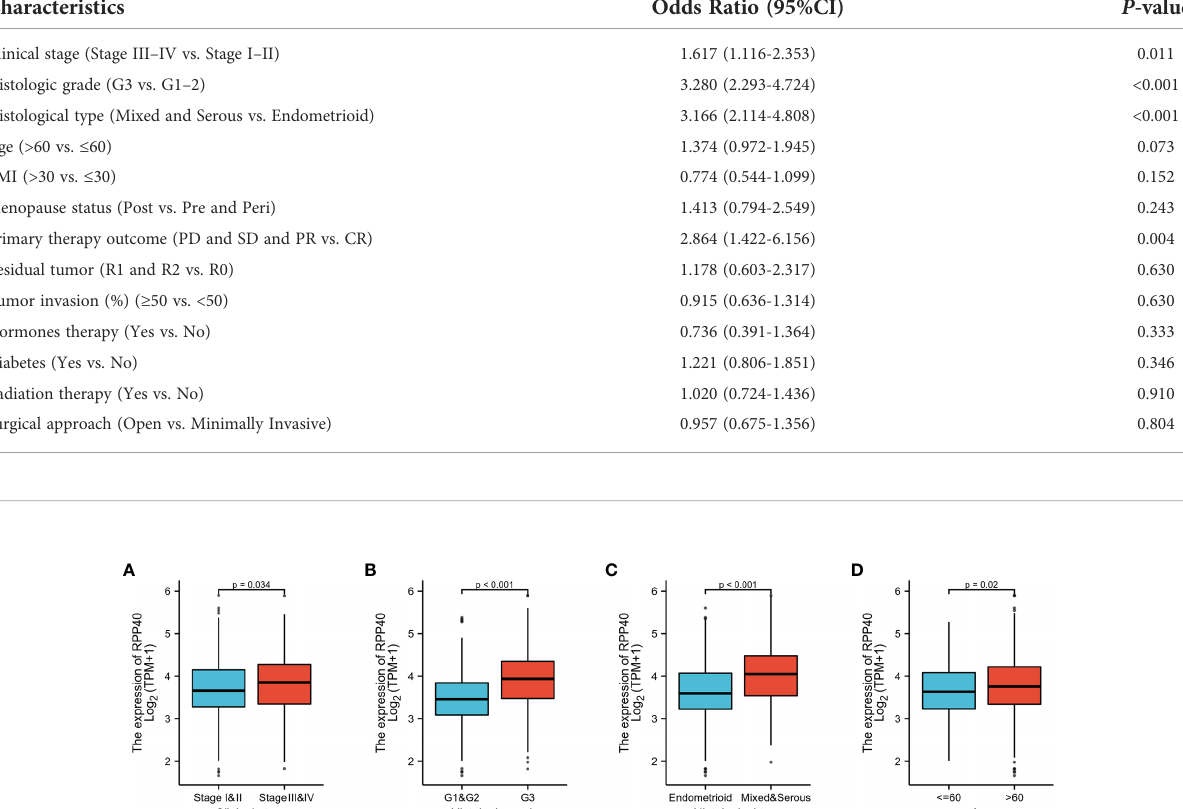
TABLE 2 Logistic regression analysis of association between clinicopathological characteristics and RPP40 expression in UCEC patients. Characteristics